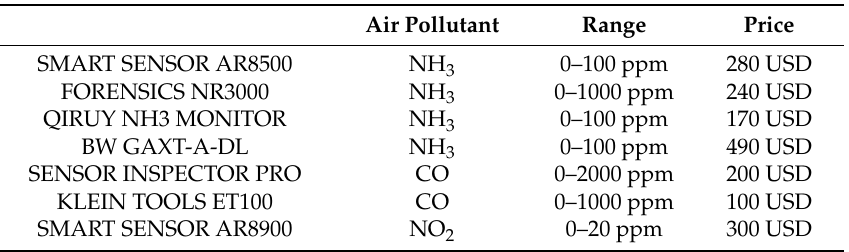
Table 3. Monitoring solutions available on the market.